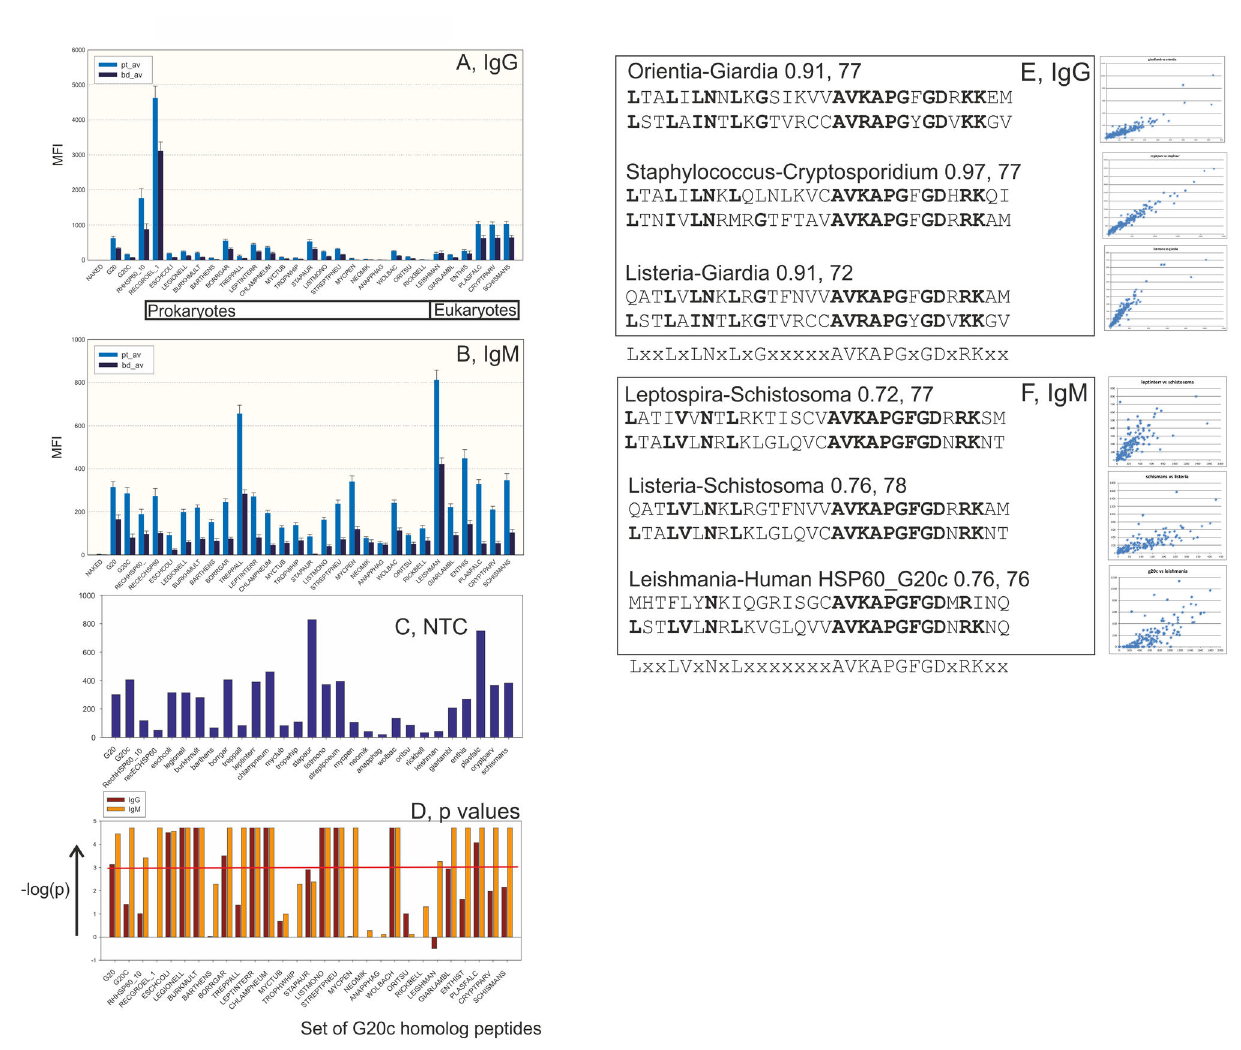
Figure 2. Phyloscan with G20c homologs of 25 bacterial and protozoal HSP60s for IgG (A) and IgM (B) binding. The average binding of patient (pt-av) and BD (bd-av) samples is shown. The relatively high NTC values (C) were partially subtracted as described in Materials and Methods. A significance test (D) using the Fisher exact test is also shown. The red line depicts a p value of 0.001. The peptides G20 (lane 1), G20c (2), recombinant human HSP60 (3) and E. coli GroEL (4) were also included. The names of the G20c homolog peptides are explained in File S1. Lanes 24-29 refer to eukaryotes. The rest are from prokaryotes. The order is the same as in the alignment of HSP60 sequences (Figure SF4 in file S1). Ordinates of sections A-C show MFI. E-F: Phylogenetic epitope definition. For each peptide pair, the correlation coefficient, the degree of sequence similarity (calculated with the BLOSUM62 scoring matrix), and the two peptide sequences, is shown. Identical peptide sequences get around 150 points with this scoring system. Three discordant sequence pairs with high IgG (E) and IgM (F) serological correlation are shown. doi: